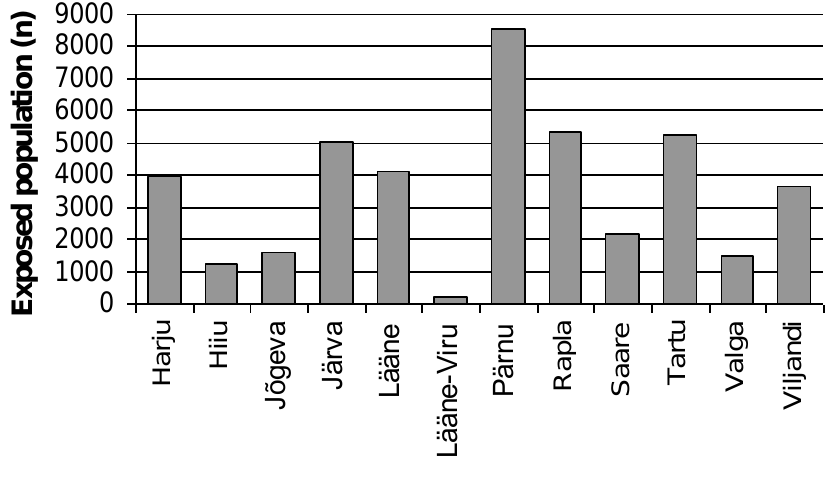
Figure 3. Distribution of population exposed to excessive fluoride levels (over 1.5 mg/L) by counties.